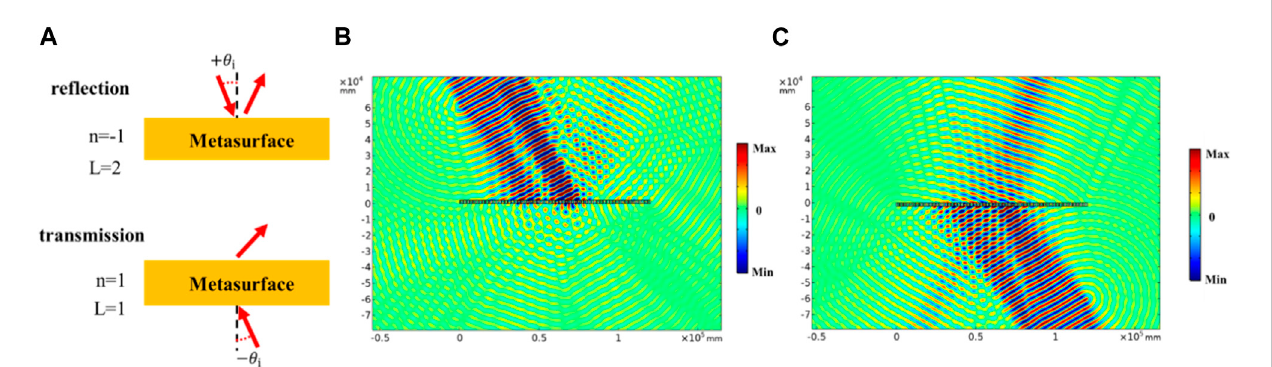
FIGURE 2 Asymmetric transmission: (A) schematic diagram, (B) normalized total acoustic pressure fi eld under a wave with the incident angle equal to 30 ° , and (C) normalized total acoustic pressure fi eld under a wave with the incident angle equal to − 30 ° .